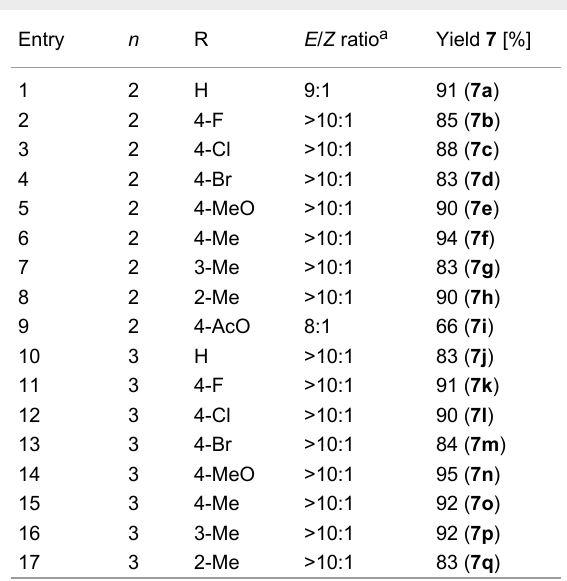
Table 3: Experimental results for acid-catalyzed dehydrations.